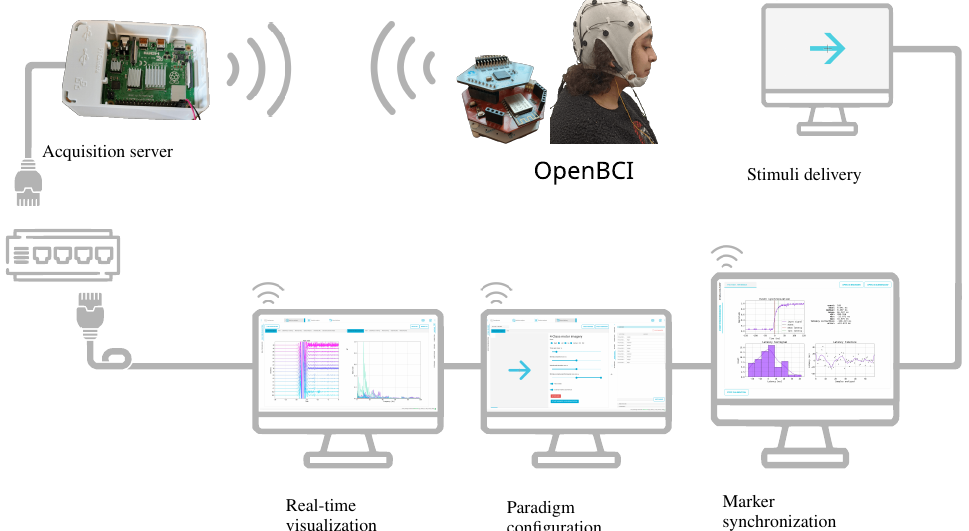
Figure 8. Implemented Motor Imagery experiment. Provided experimental setup utilizes a dedicated wireless channel for data acquisition and a wired connection for the distributed systems, enclosing real-time visualization, marker synchronization, paradigm configuration, and stimuli